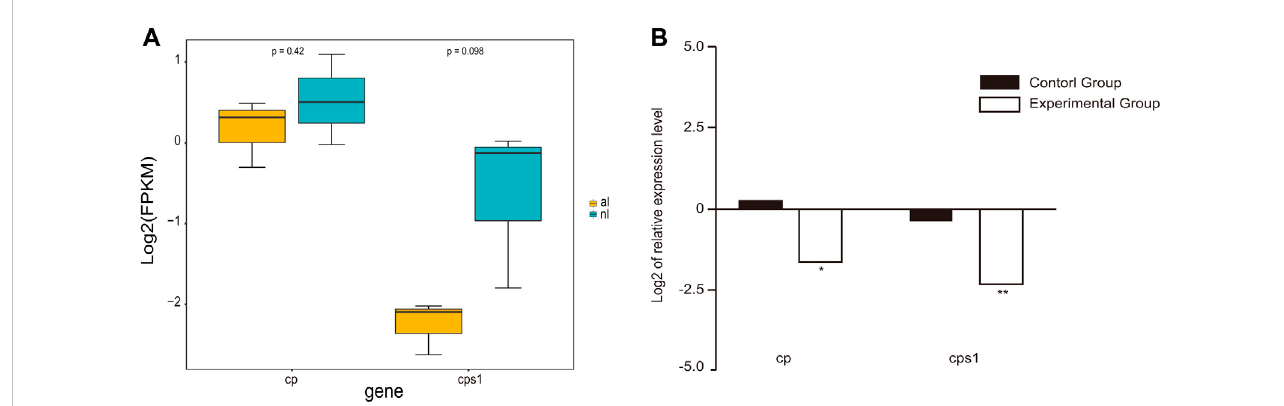
FIGURE 5 Geneexpression inthe lungs. (A) Expression ofcp and cps1 genes inthelungsof non-aestivatingand aestivatinglung fi sh. (B) Validationof RNA-seq data using quantitative real-time PCR